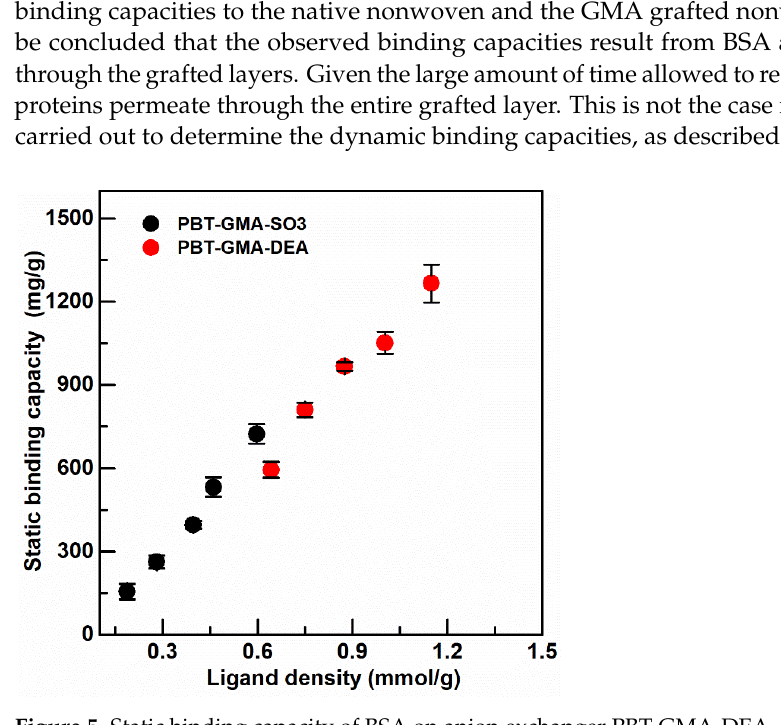
Figure 5. Static binding capacity of BSA on anion exchanger PBT-GMA-DEA, and of hIgG on cation exchanger PBT-GMA-SO 3 membranes at different ligand densities.